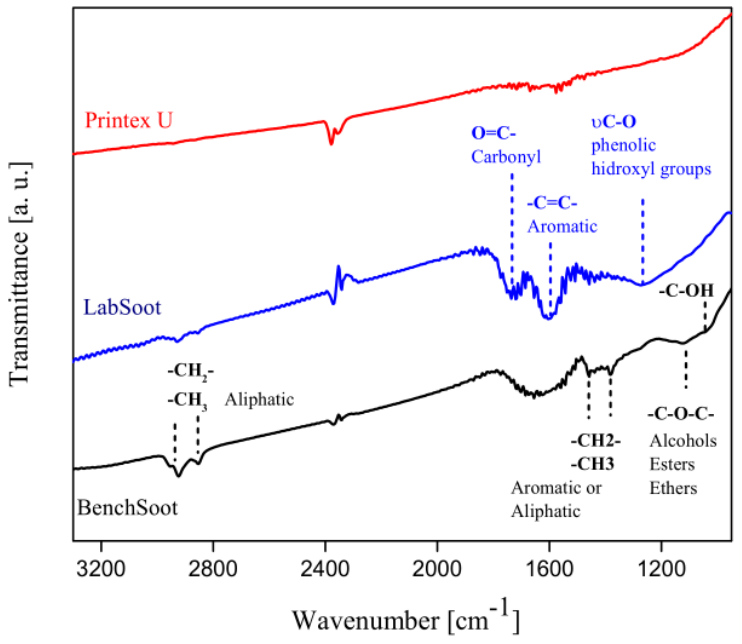
Figure 2. Infrared spectra of soot